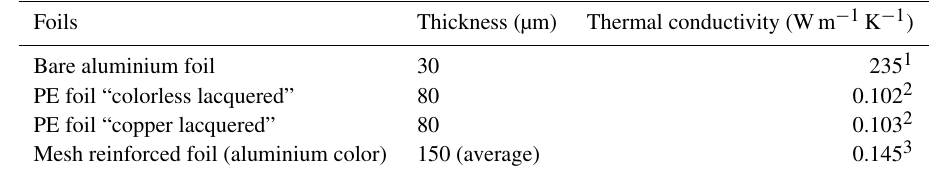
Table 4. Thicknesses and thermal conductivities of the four different types of foils selected for emissivity measurement.